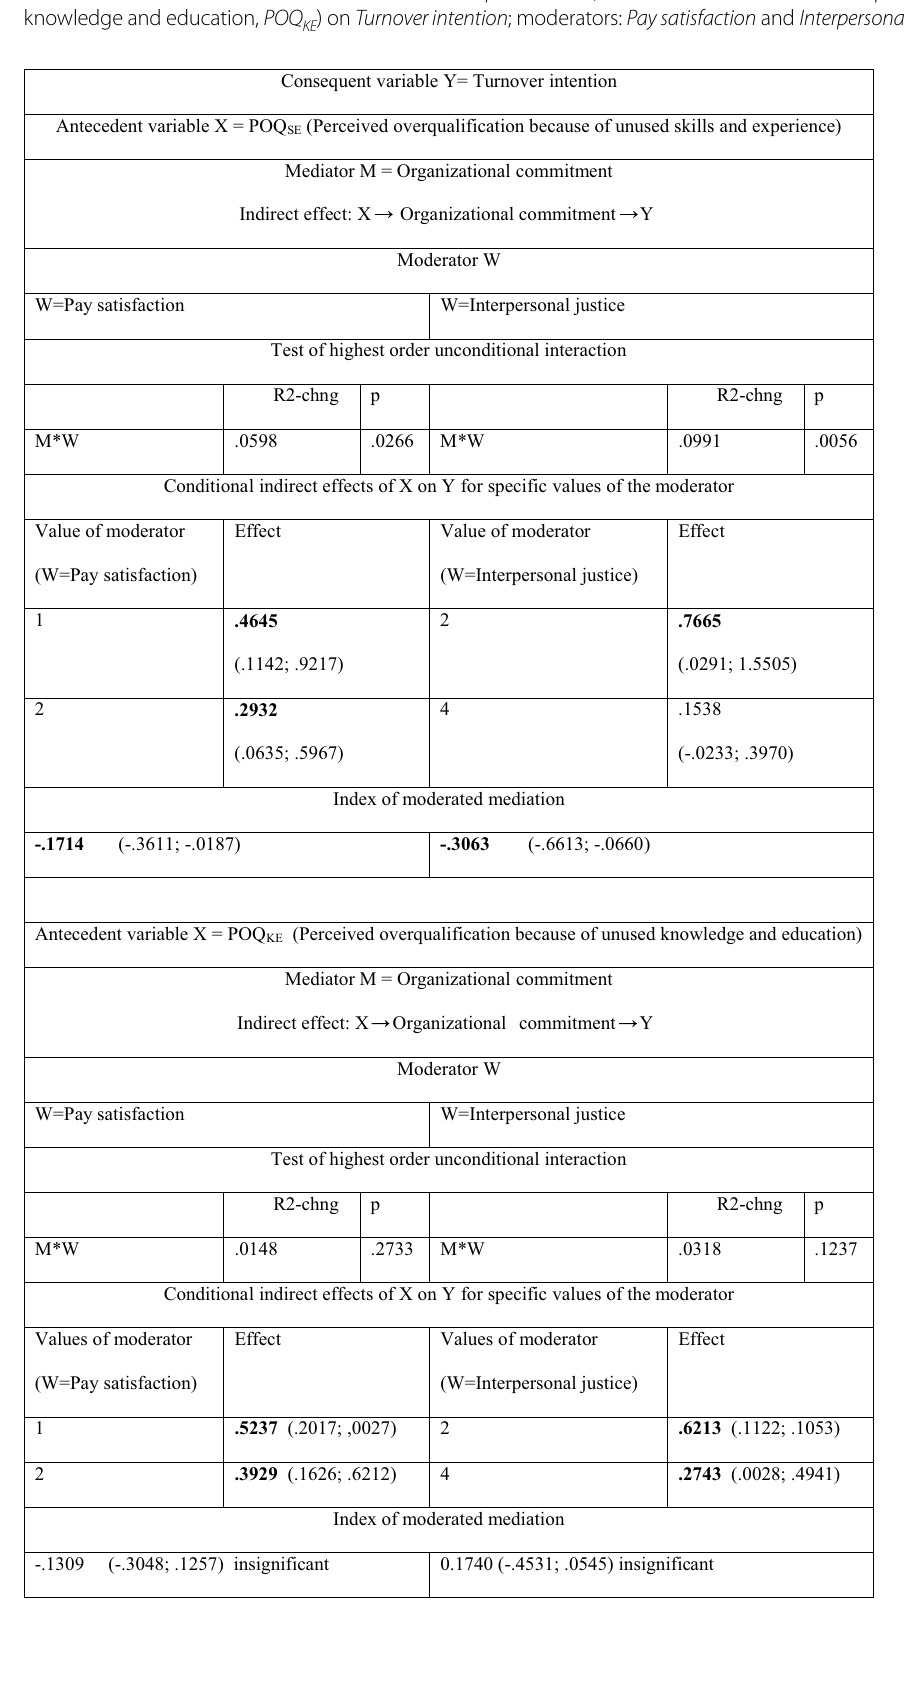
, and because of unused SE